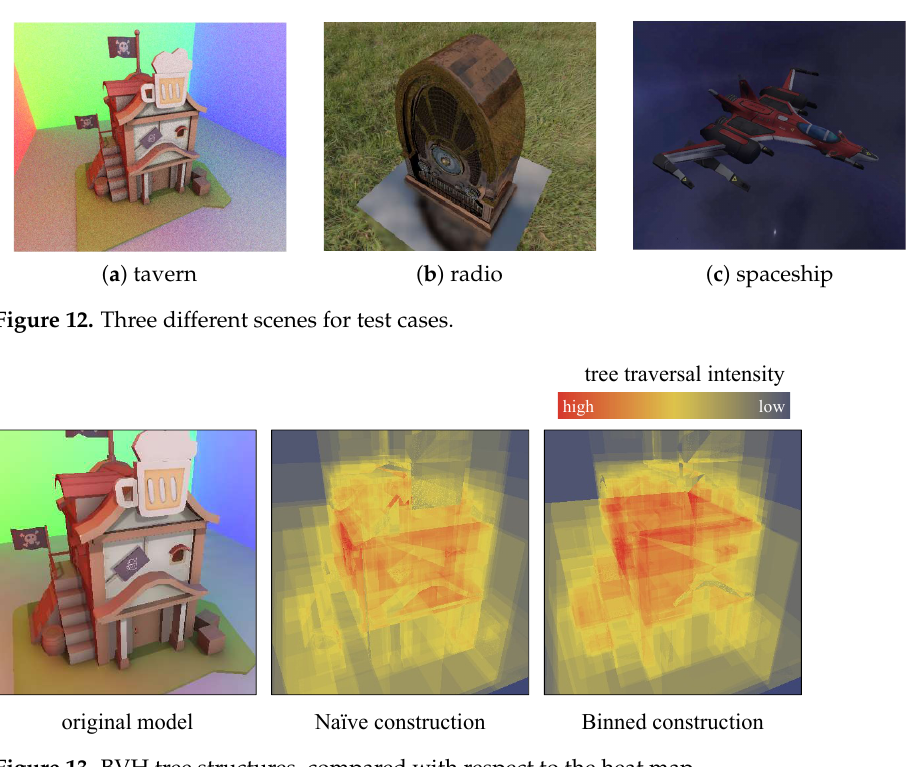
Figure 13. BVH tree structures, compared with respect to the heat